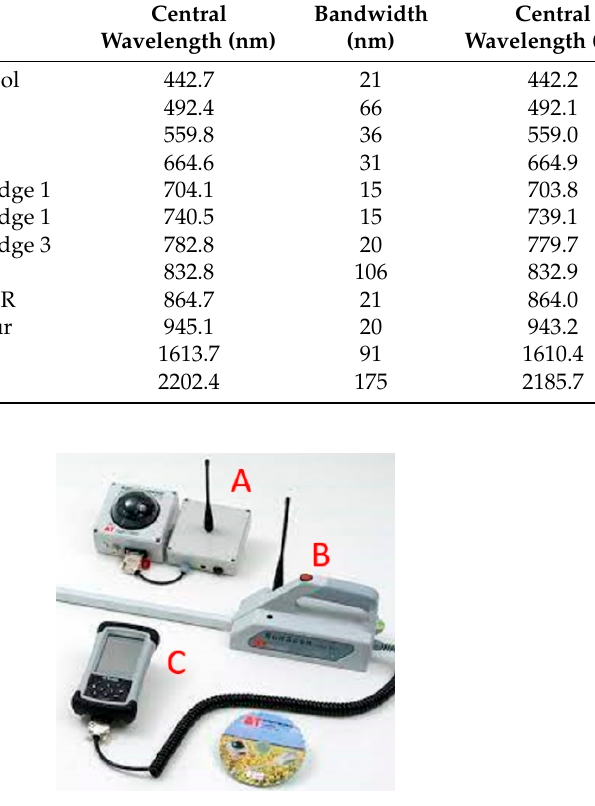
Figure 1. Locations and analysis polygons of the experiments conducted in Israel in 2018–2020.